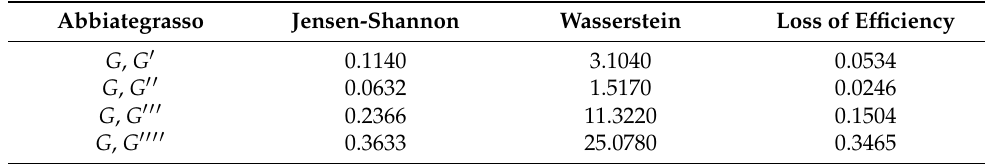
Table 6. Probabilistic distances vs. loss of efficiency. Abbiategrasso